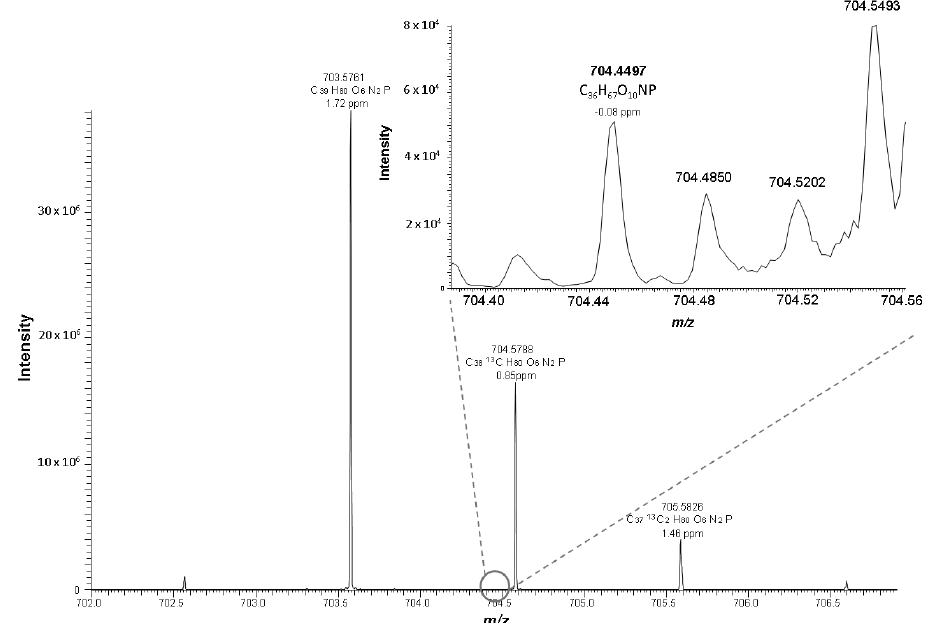
Figure 2. Positive ESI mass spectrum of oxidized LDL at the retention time 11.38 min. In the depicted spectrum PC 18:0_10:3[2O] at m / z 704.4497 co-elutes at the same retention time as SM 16:0 and has the same nominal mass as the M+1 peak of SM 16:0 ( m / z